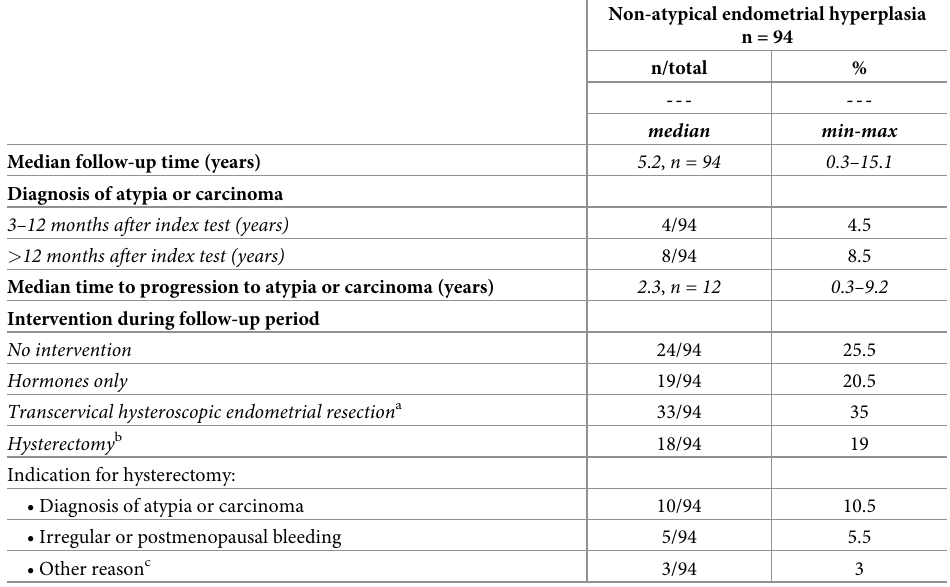
Table 4. Results of follow-up in women who remained at risk more than three months after initial diagnosis of non-atypical endometrial